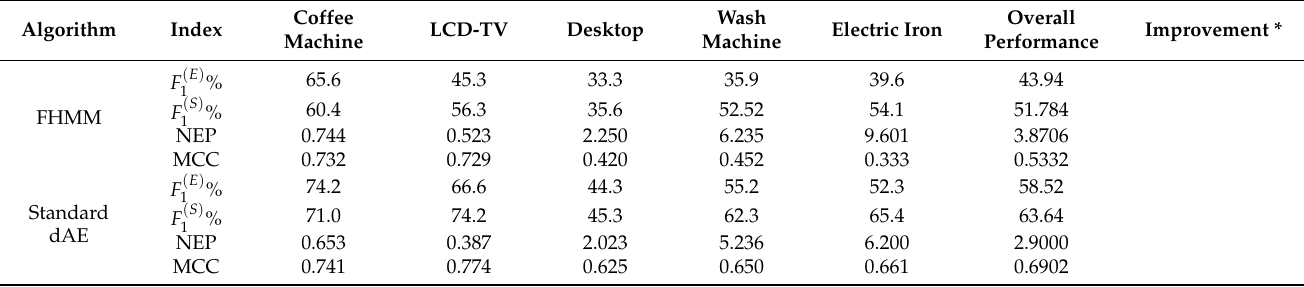
Figure 9. PC load identification results over a period of 15,000–25,000 s. Table 2. Comparison of identification indexes of several equipment using TraceBase